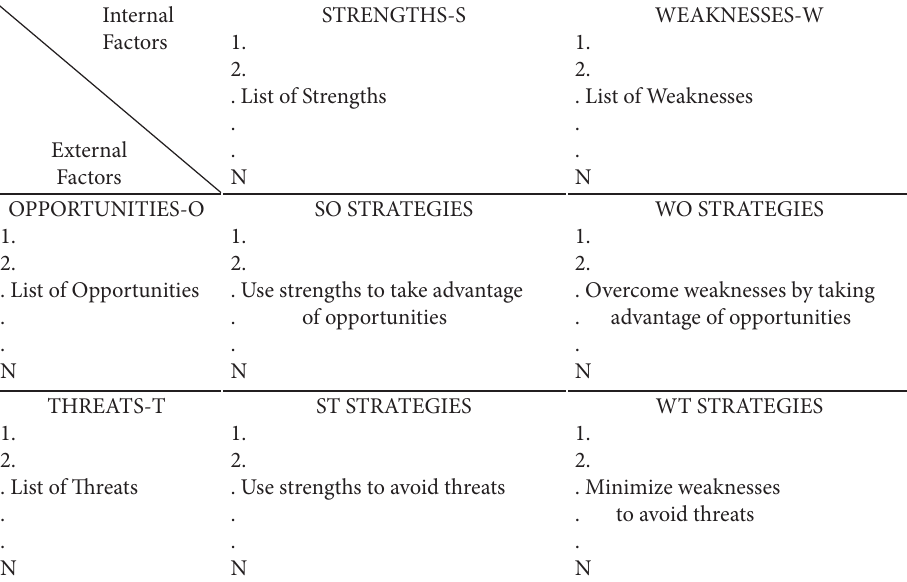
Table 4. A generic presentation of the SWOT matrix (Sevkli et al.